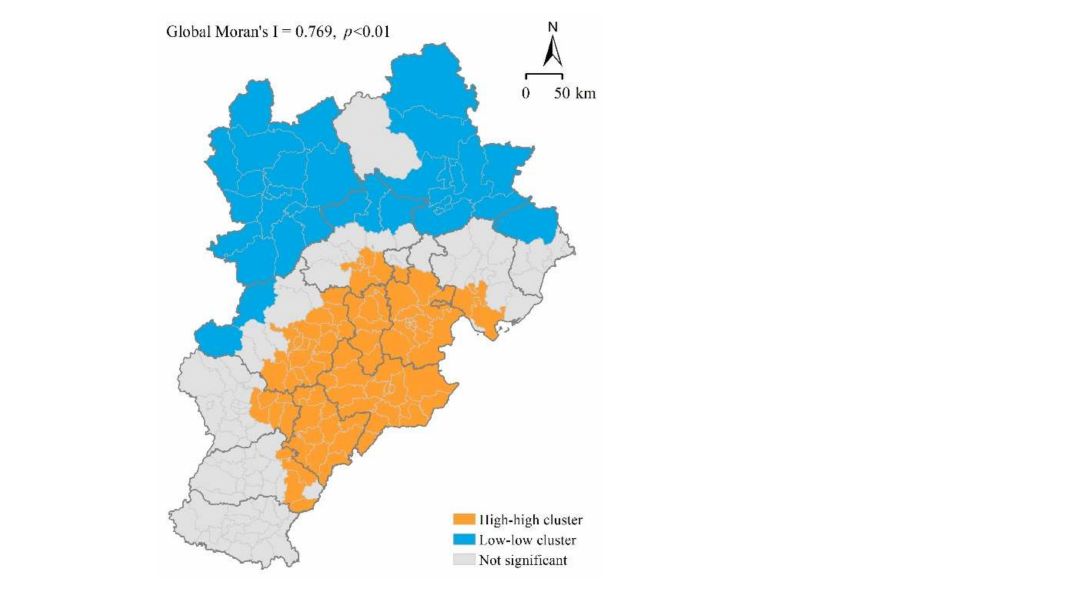
Figure 3. Local indicators of spatial association of PM 2.5 concentrations in the Beijing–Tianjin–Hebei urban agglomeration in 2015.